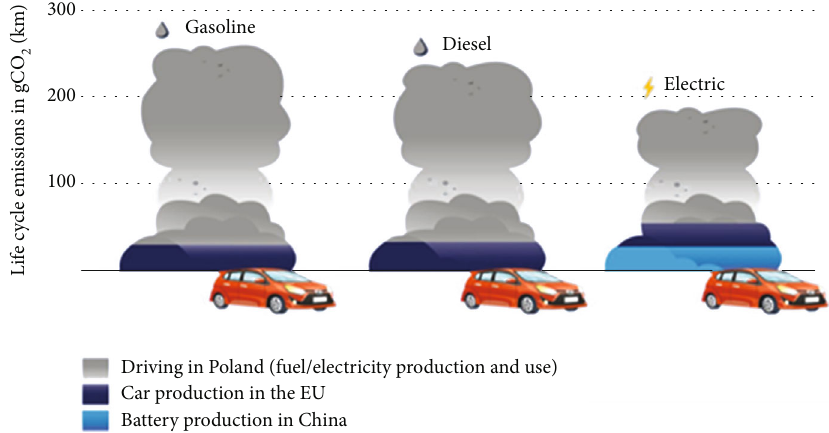
Figure 3: The lifetime carbon dioxide (CO